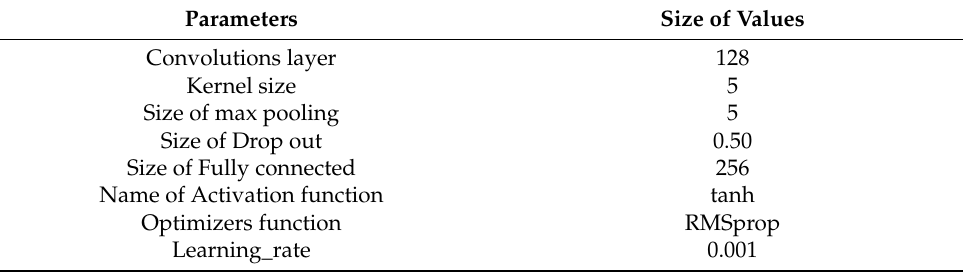
Figure 7. The structure of the CNN–LSTM mode. Algorithm 1. Algorithm of CNN–LSTM Table 4. Parameters of the proposed